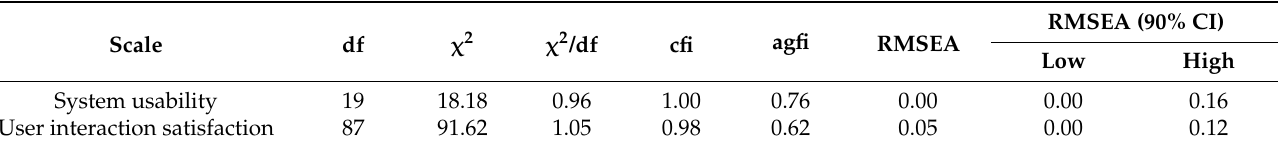
Table A10. The values of construct validity of the scales of the two aspects of system usability and user interaction satisfaction computed by the CFA.